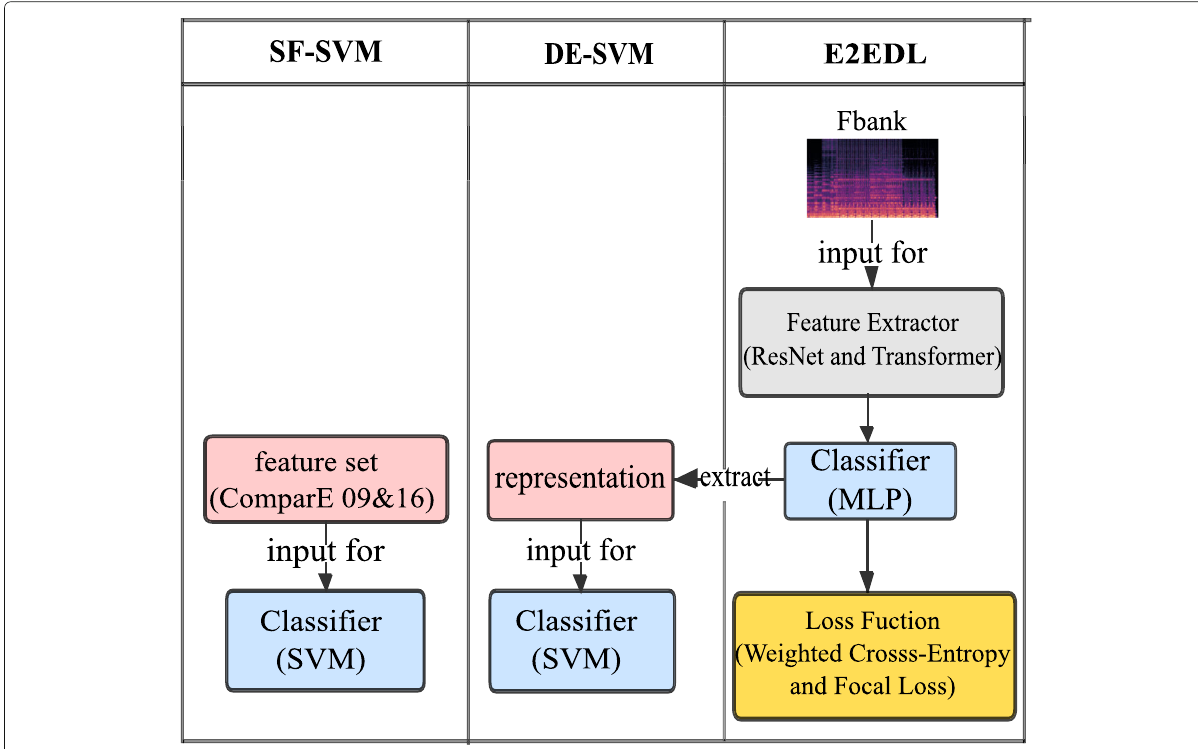
Fig. 3 The proposed three